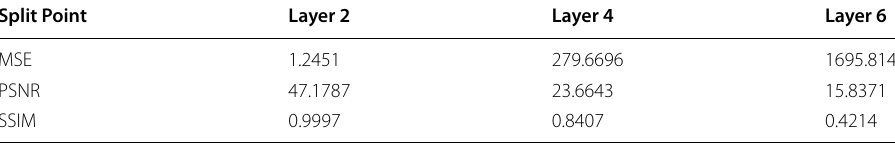
Table 1 MSE, PSNR, SSIM for black-box reconstruction attack with different split